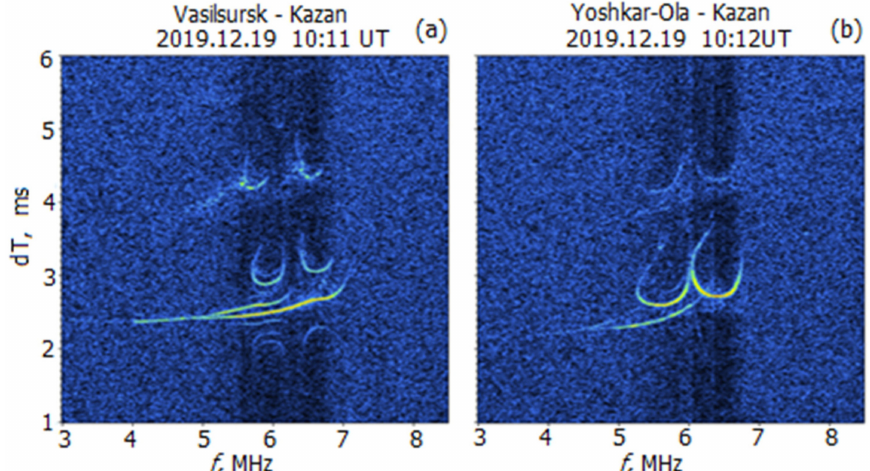
Figure 5. RFC recorded on 19 December 2019. ( a ) Vasilsursk-Kazan path, 10:11 UT; ( b ) Yoshkar-Ola- Kazan path, 10:12 UT.